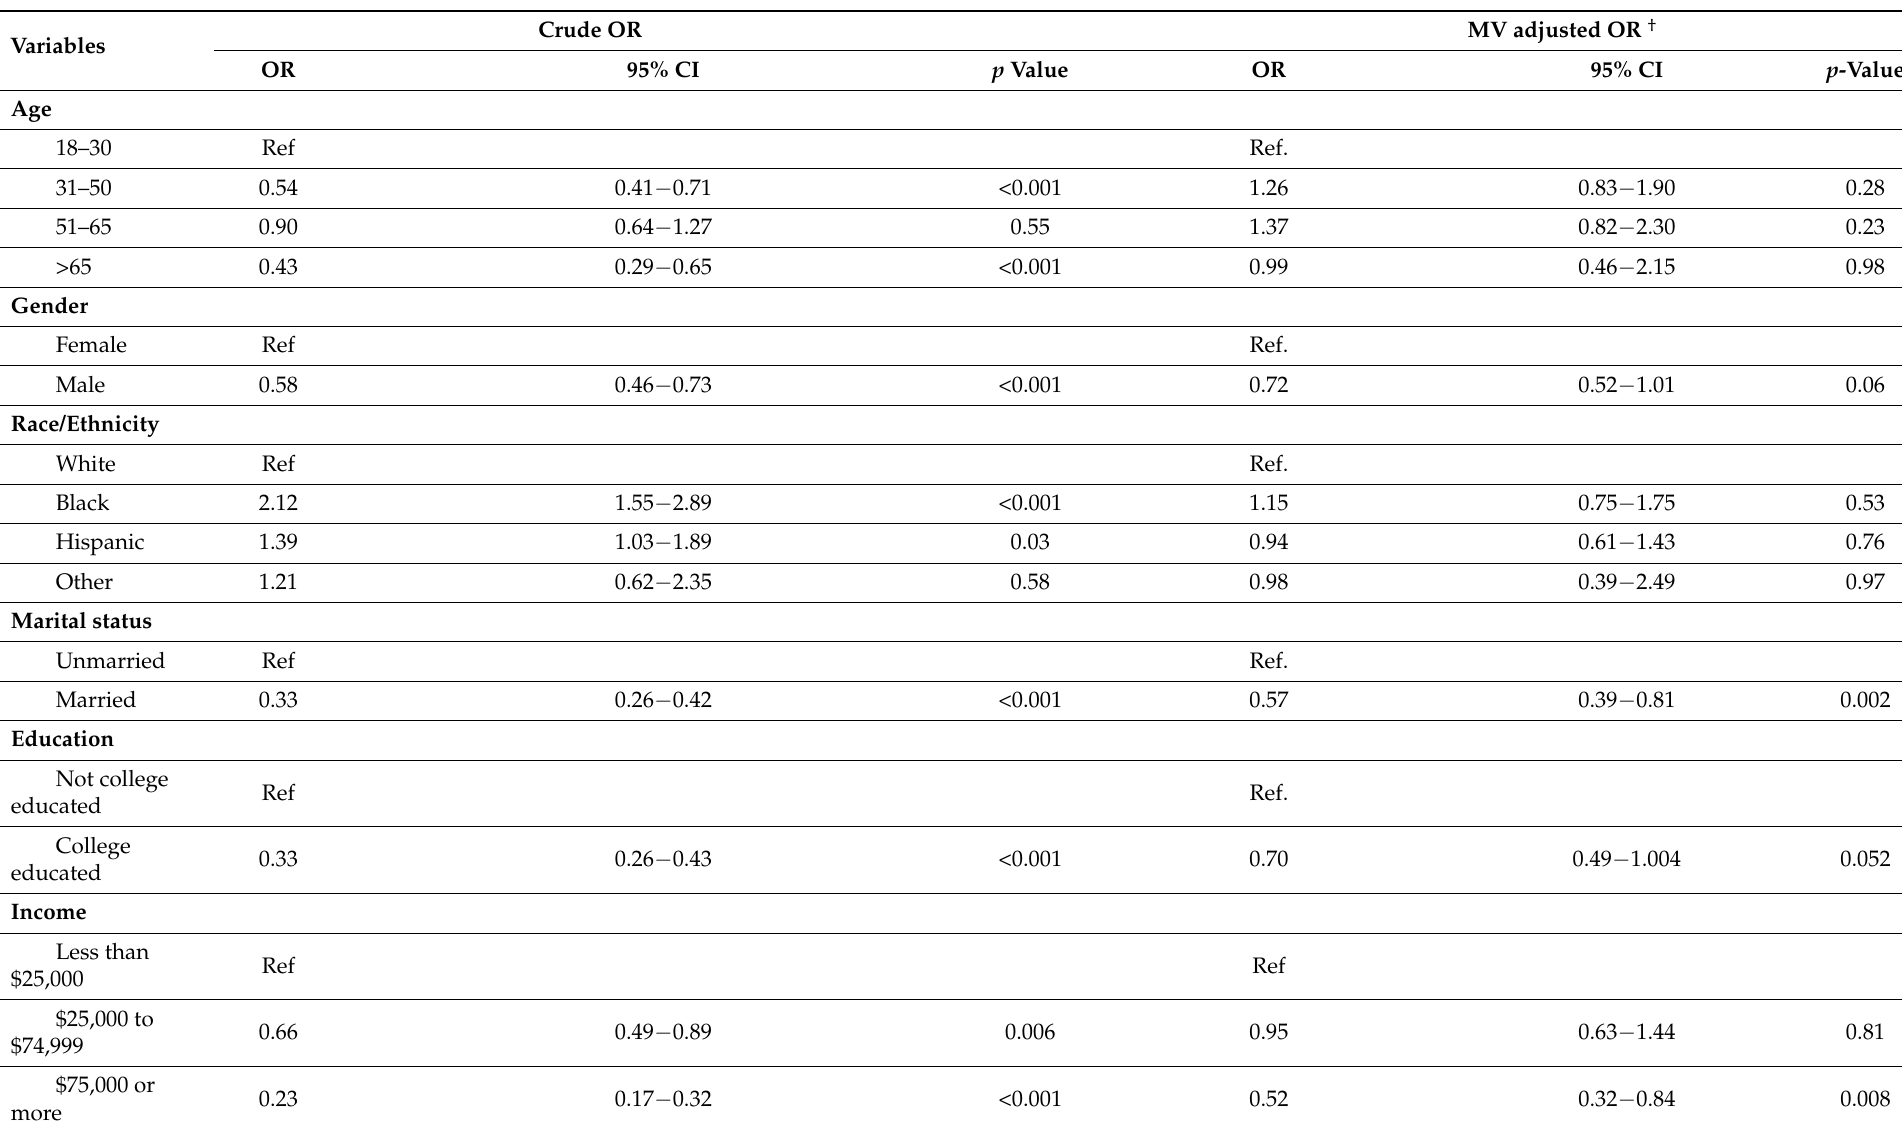
Table 2. Univariate and multivariable analysis for vaccine hesitancy